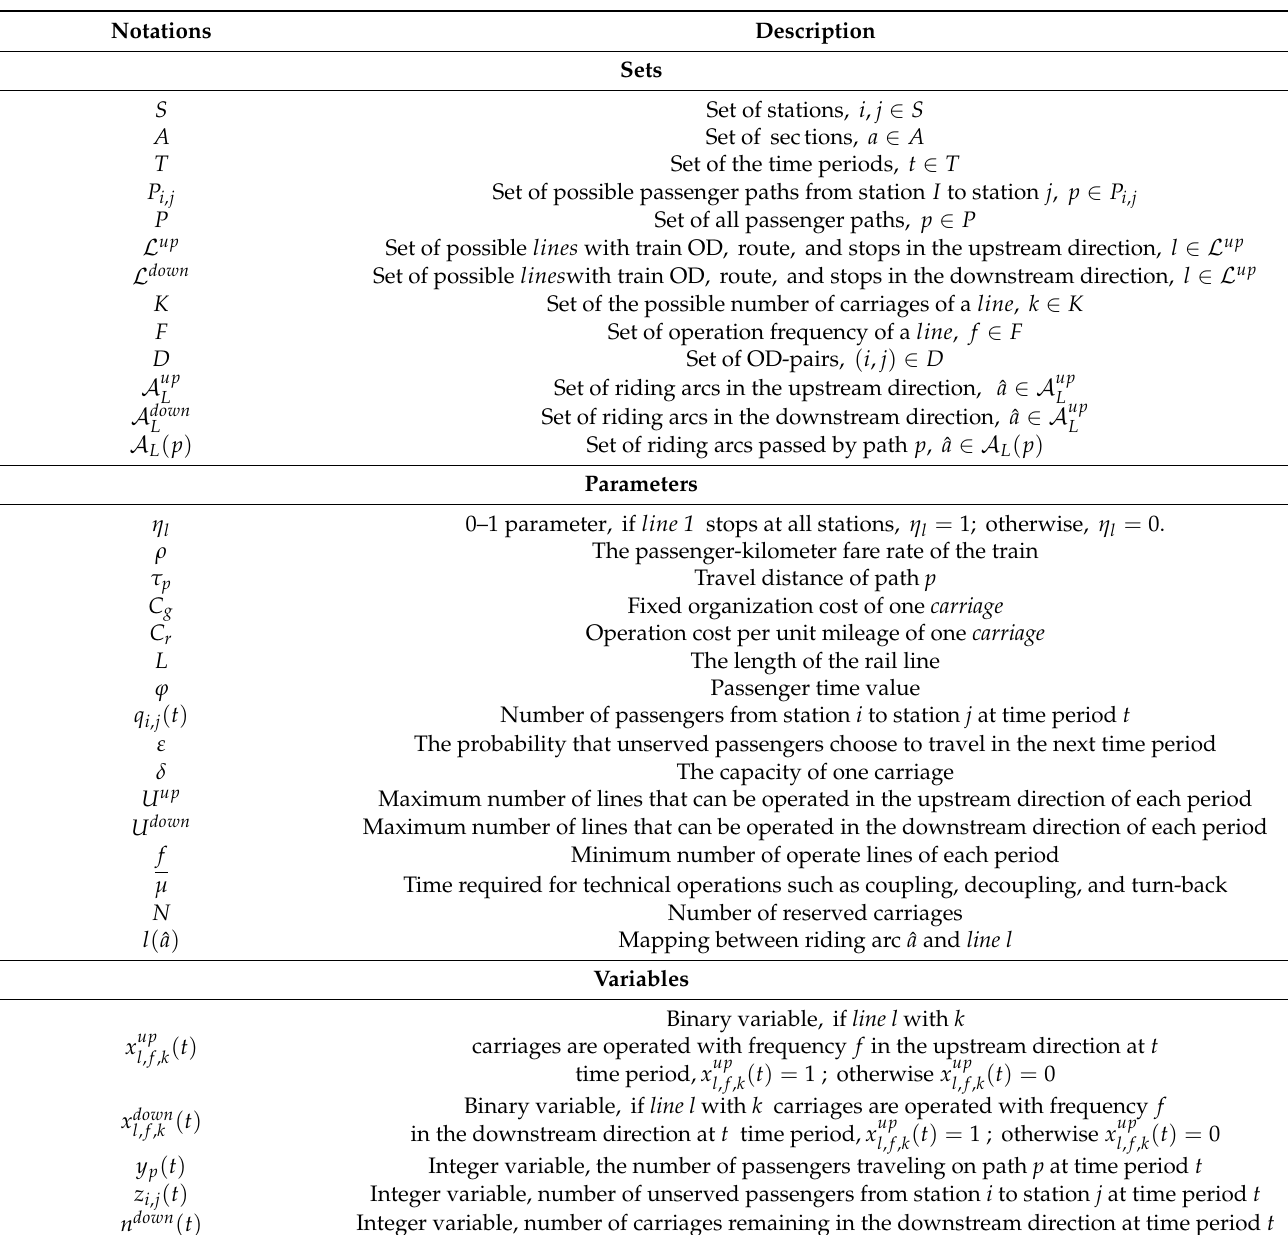
Table 1. Parameters, decision variables, and